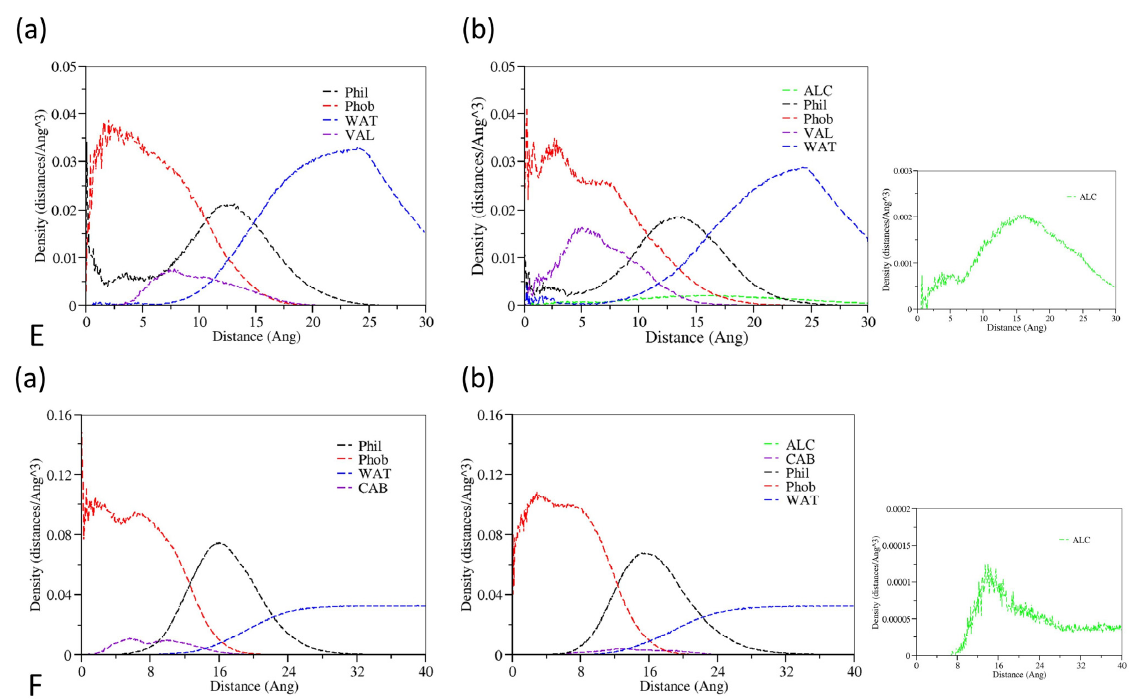
Figure 4. Radial density distributions for various molecular groups against the center core of micelle of ( a ) the formulations without cosolvents and ( b ) the formulations containing cosolvents. ( A ) represents the Cyclosporine system, ( B ) represents the Docetaxel system, ( C ) represents the Etoposide system, ( D ) represents the Paclitaxel system, ( E ) represents the Valrubicin system, and ( F ) represents the Cabazitaxel system. Red represents the hydrophobic groups of the surfactants, black represents the hydrophilic groups of the surfactants, blue represents the water molecules, purple represents the drug molecules, green represents the ethanol molecules, and pink represents PEG 300.